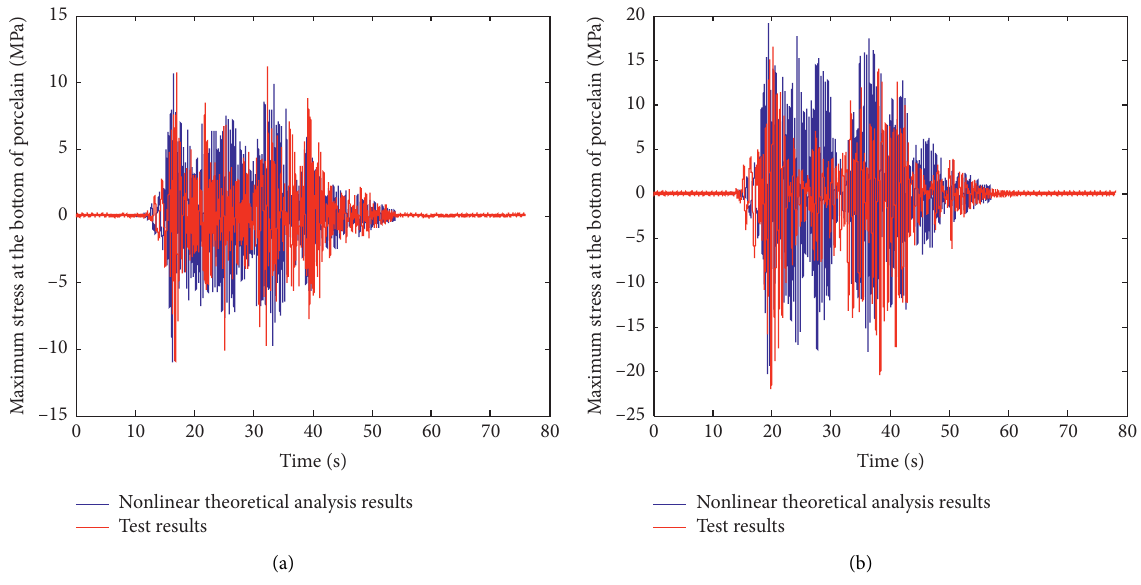
Figure 12: Comparative diagram of maximum stresses at the bottom end of porcelain pillars. (a) 0.15 g. (b) 0.3g.